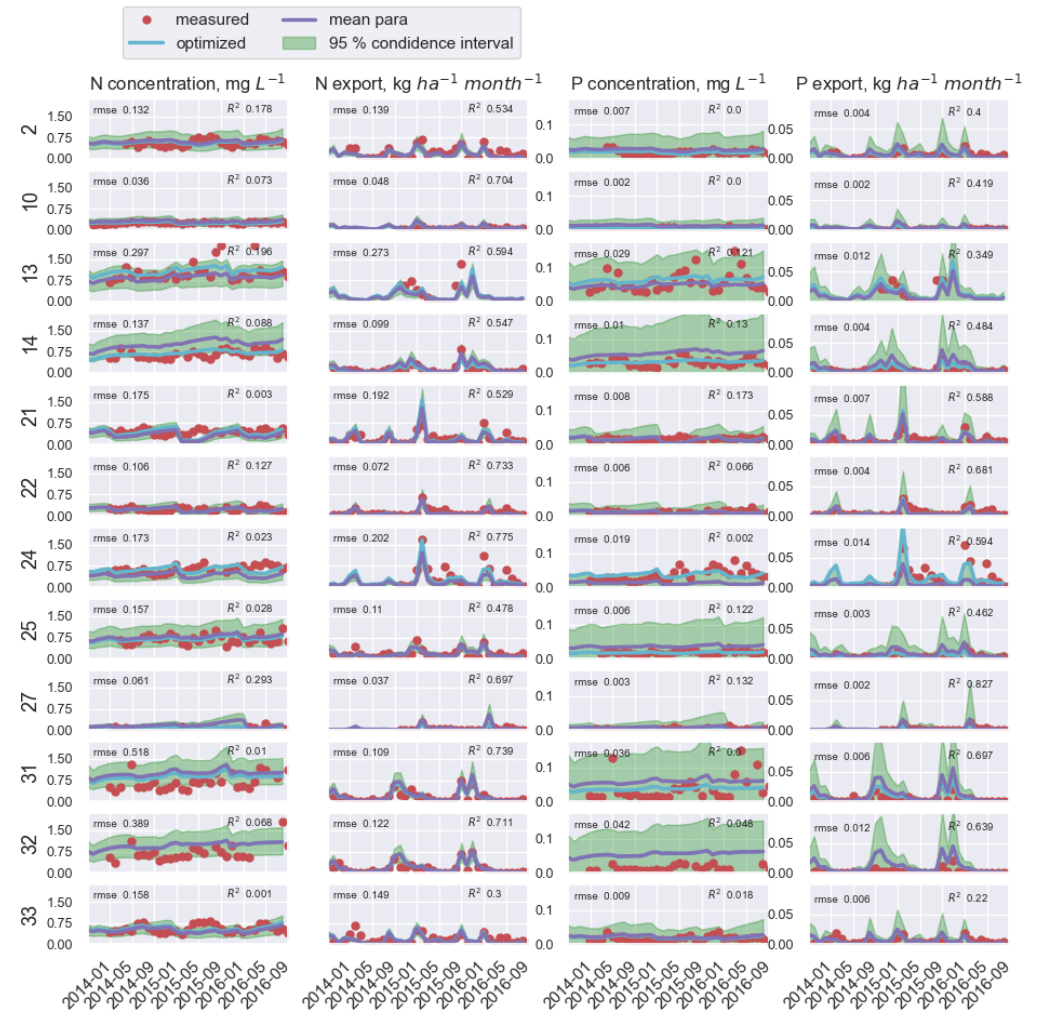
Figure 3. Observed total nitrogen (N) and phosphorus (P) concentration in stream water and export in the calibration catchments (red dots, catchment number as y label). The green and blue lines show mean modeled values with optimized immobilization parameters and those derived from catchment properties, respectively. The green range shows a 95% confidence interval. Units for each figure column are given as a column